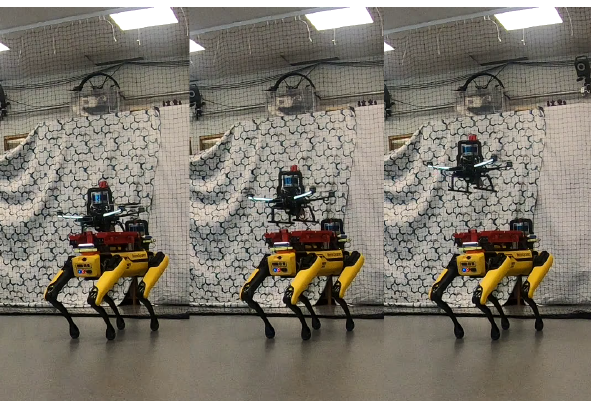
Figure 14. Autonomous take-off of the Shafter drone from the platform while Spot robot is in standing